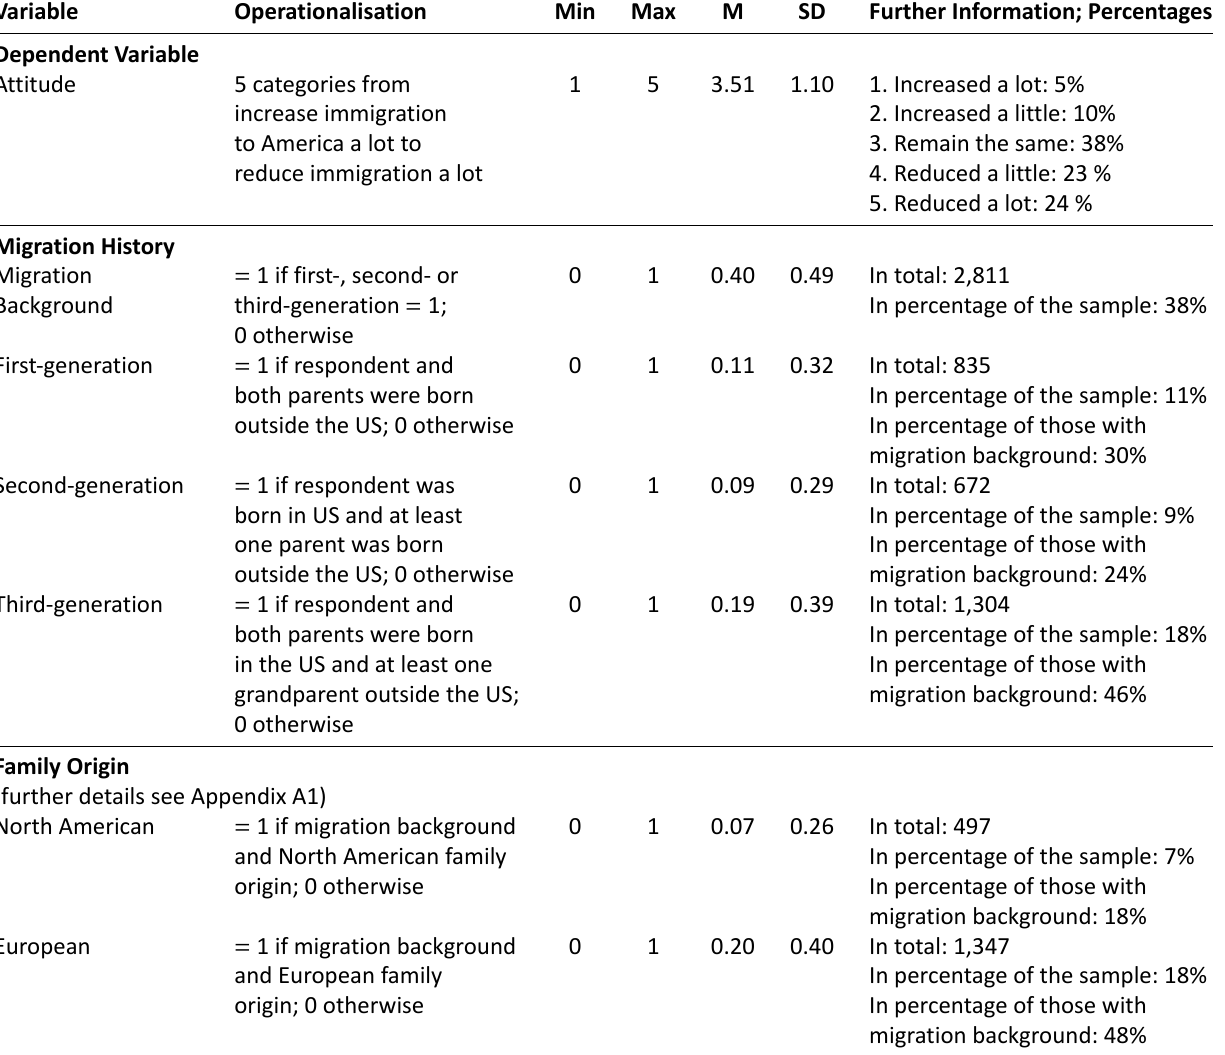
Table A2. Variables used in the analyses and descriptive statistics.